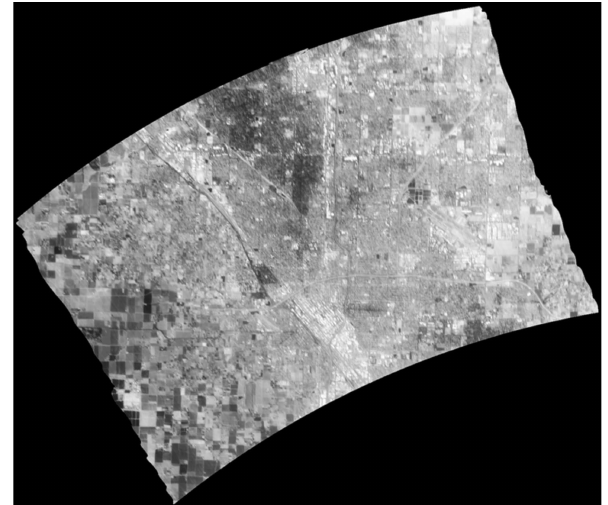
Fig. 5. Georectification and map projection at Level 1B2 makes use of high frequency navigation information to correct for distortions due to aircraft attitude fluctuations. Here, the data from Fig. 4 have been mapped to a Universal Transverse Mercator